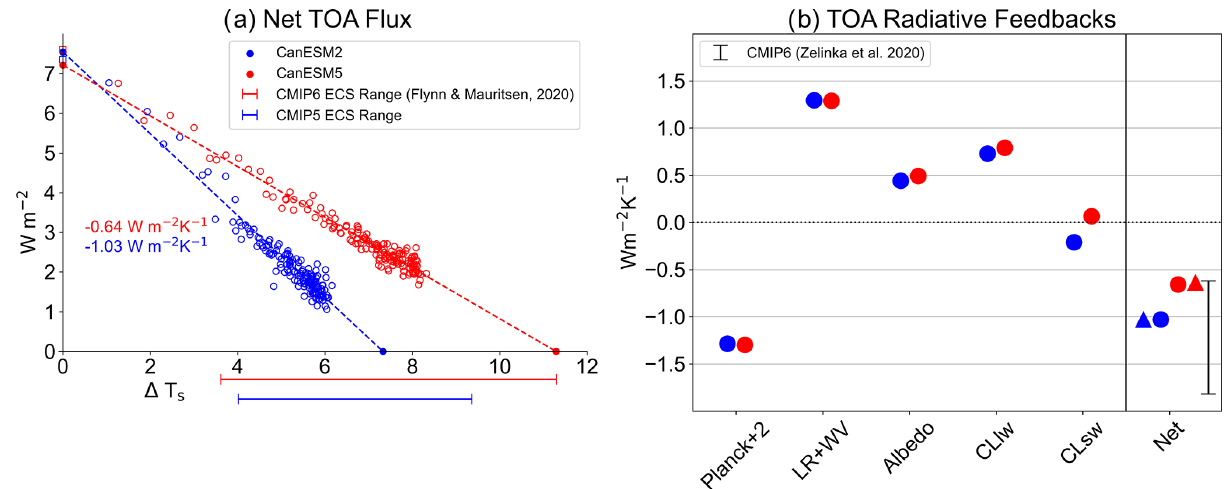
Figure 1. (a) Net top-of-atmosphere (TOA) radiation plotted against global annual mean surface air temperature change in abrupt 4 × CO 2 simulations for CanESM2 (blue) and CanESM5 (red). Standard 150-year Gregory regressions using net top-of-atmosphere radiative flux (adjusted by a pre-industrial 150-year annual mean control climate) are conducted, where the x axis intercept of the regression line divided by two is defined as the EffCS, and the y axis intercept is defined as the ERF. For comparison, the ERF, as calculated using fixed SST AMIP-style runs, is shown for both versions of CanESM via the open squares along the y axis. Bars below the x axis denote the model range for EffCS for both CMIP5 and CMIP6 (Flynn and Mauritsen, 2020). (b) Global annual mean top of atmosphere radiative feedbacks calculated using radiative kernels (in Wm − 2 K − 1 ). From left to right, feedbacks are listed as “Planck+2” (a value of 2 was added for display purposes to better illustrate differences in the other feedbacks), lapse rate plus water vapour, surface albedo, cloud, and net feedback. For comparison, we also show the net climate feedback value obtained using the standard Gregory regression approach (filled triangles), as well as the CMIP6 model range (Zelinka et al.,